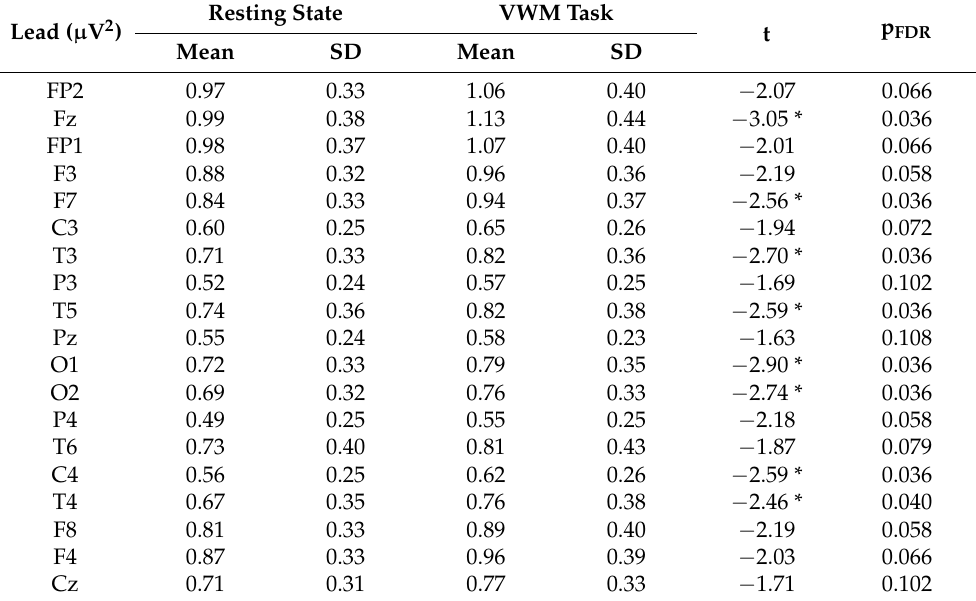
Table 2. Comparisons of absolute theta power during the resting state and the retention interval of the VWM task in healthy volunteers. Lead ( µ V 2